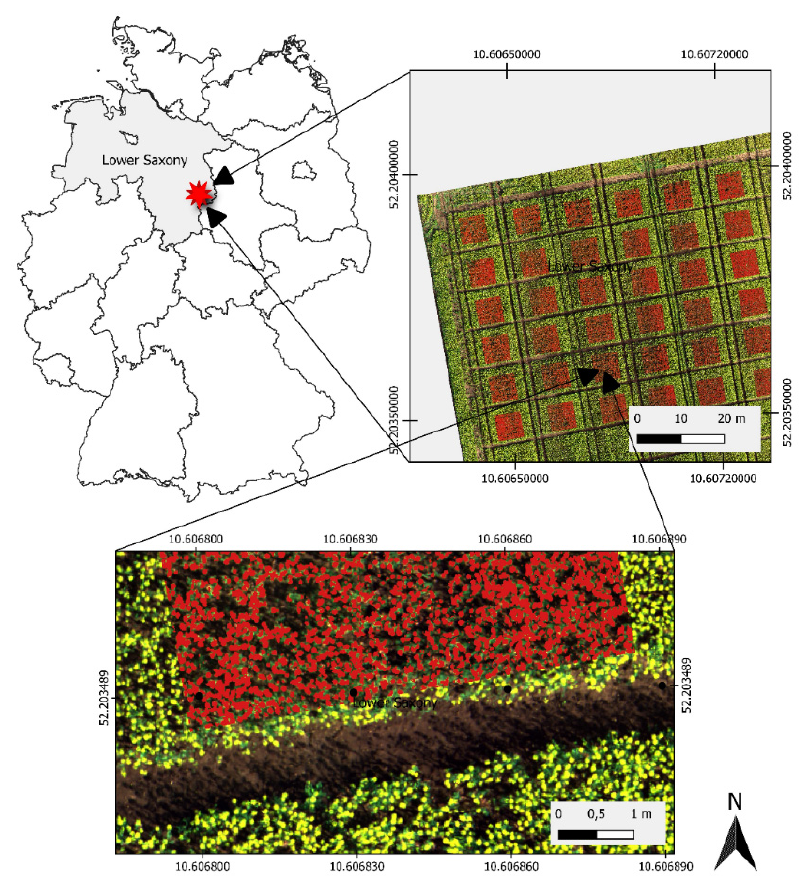
Figure 1. The general location of experimental trials and the overview of the images obtained by unmanned aerial vehicle (UAV) remote sensing platform for the oilseed rape field in Salzdahlum, Lower Saxony, Germany. The image was acquired on 30 April 2020.